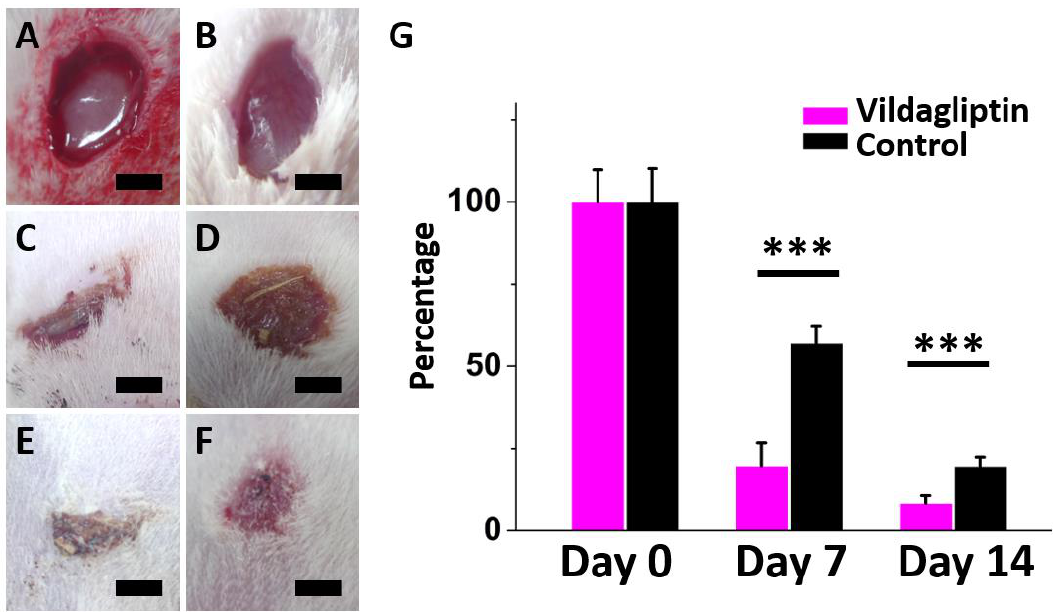
Figure 5. Progress of wound recovery following treatment in both groups on day 0 (( A ): vildagliptin group; ( B ): control group)), day 7 (( C ): vildagliptin group; ( D ): control group)), and day 14 (( E ): vildagliptin group; ( F ): control group)). The residual percentage of diabetic wounds treated with both groups after one and two weeks ( G ) (*** p < 0.001) (scale bar = 5 mm).